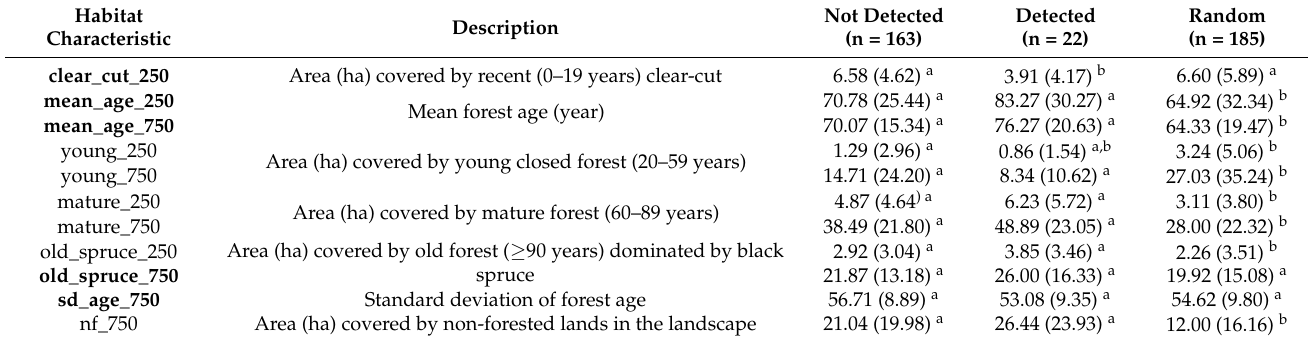
Table 1. Description and mean values ± standard deviation (s.d.) of habitat characteristics measured at the stand (250 m-radii) and landscape (750 m-radii) scales at stations where the American Three-toed Woodpecker was detected, not detected and at random stations during occupancy surveys in managed boreal forest in eastern Canada. Shared letters indicate no significant differences in habitat characteristics among stations (Kruskal–Wallis test). Habitat characteristics in bold are included in occupancy